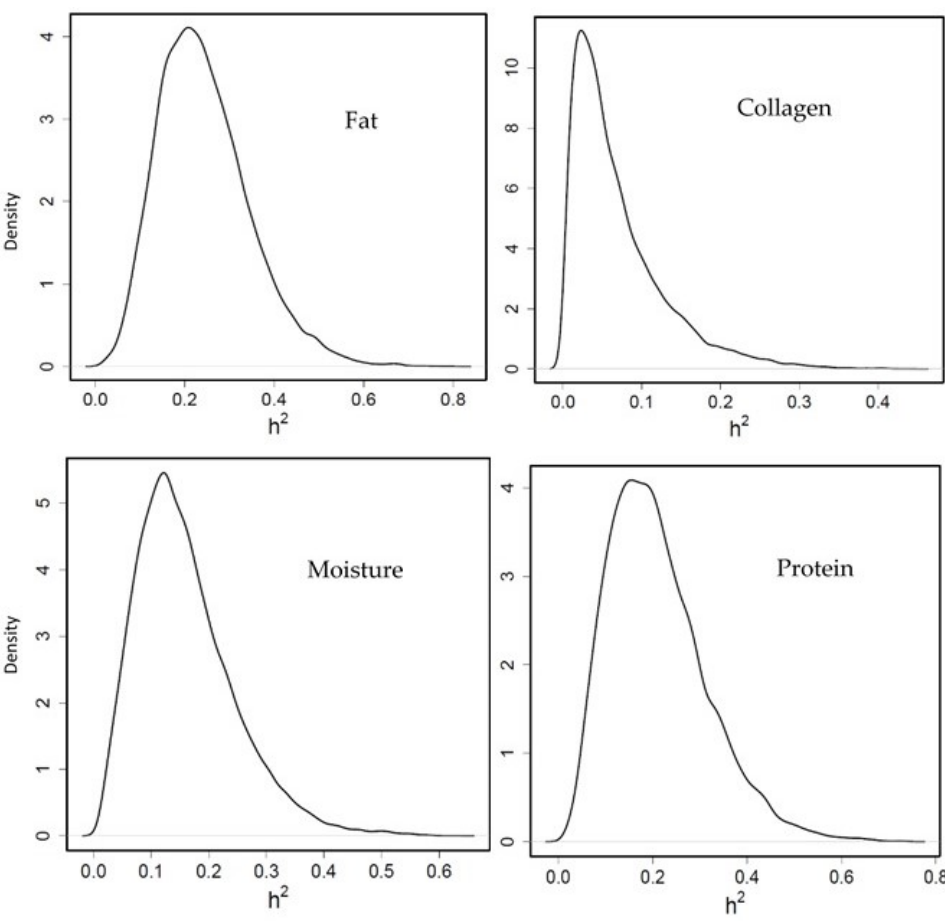
Figure 2 . Posterior marginal distribution of heritabilities of fillet fat, collagen, moisture and protein percentage in gilthead seabream. h2 = heritability. (n = 399).